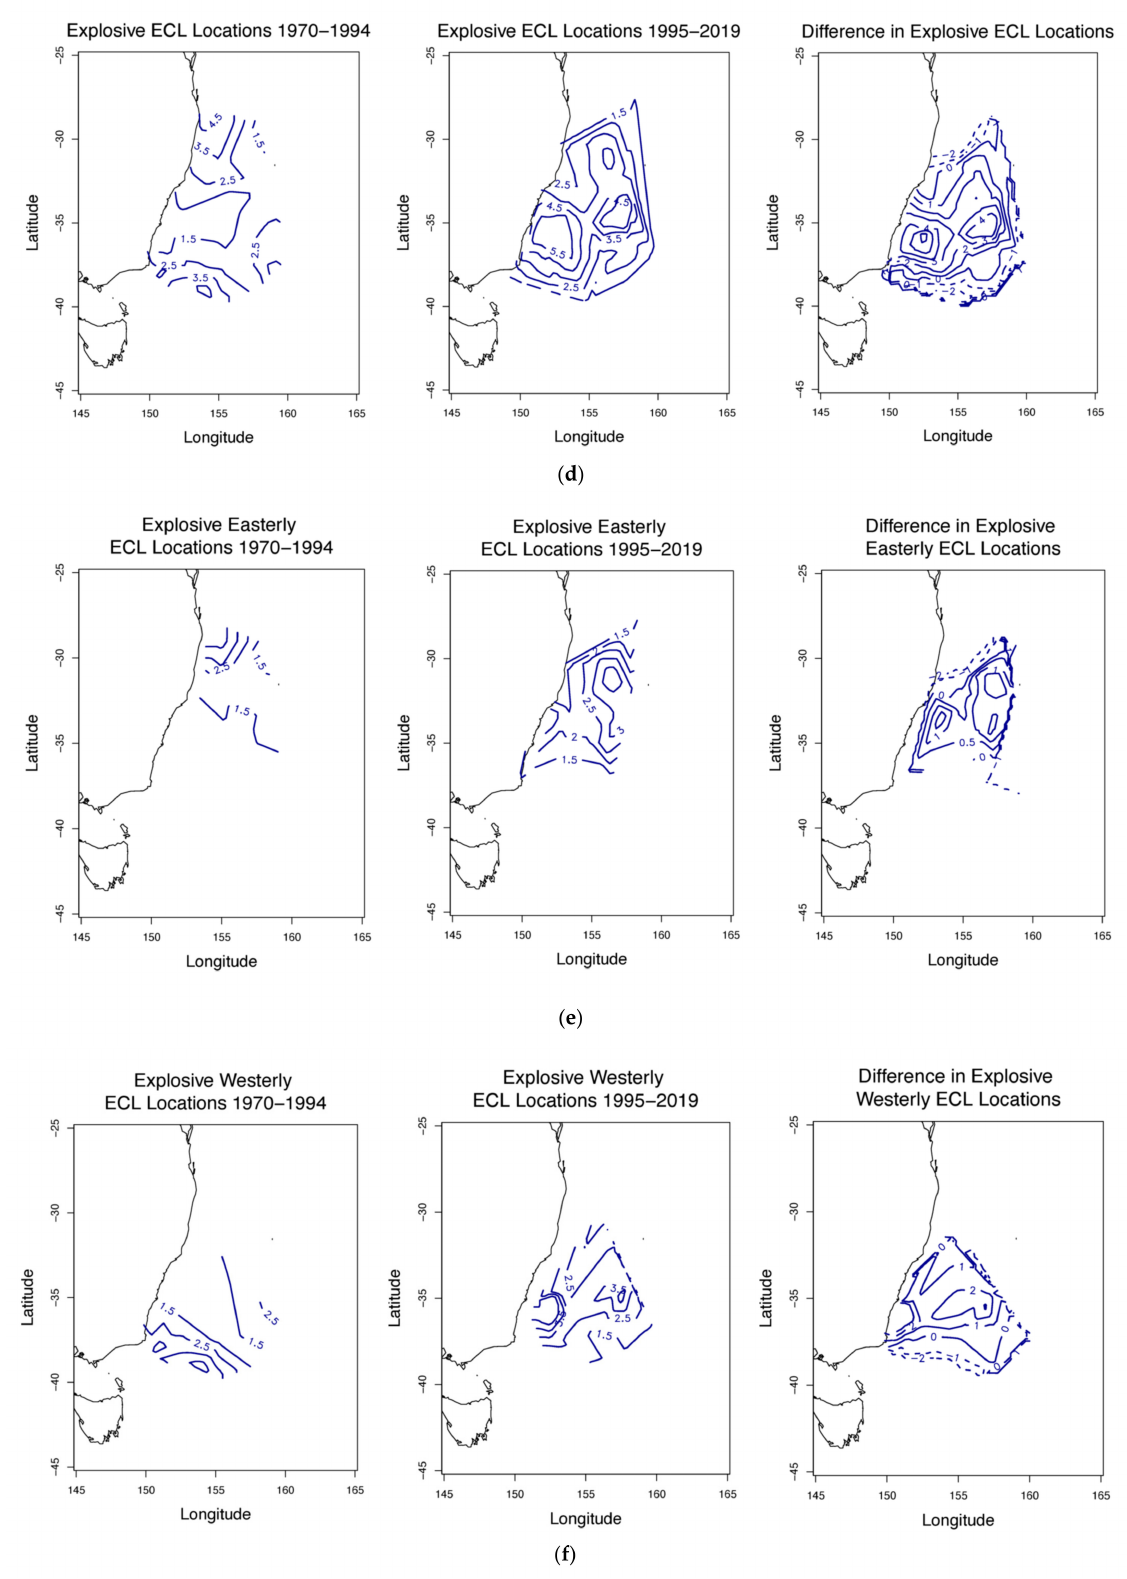
Figure 7. Point density estimate (PDE) contours of ECL locations April–September 1970–1994 (left panel), 1995–2019 (middle panel), and the difference 1995–2019 minus 1970–1994 (right panel), for ( a ) Total, ( b ) Easterlies, ( c ) Westerlies, ( d ) Total Explosive, ( e ) Explosive Easterlies, and ( f ) Ex-plosive